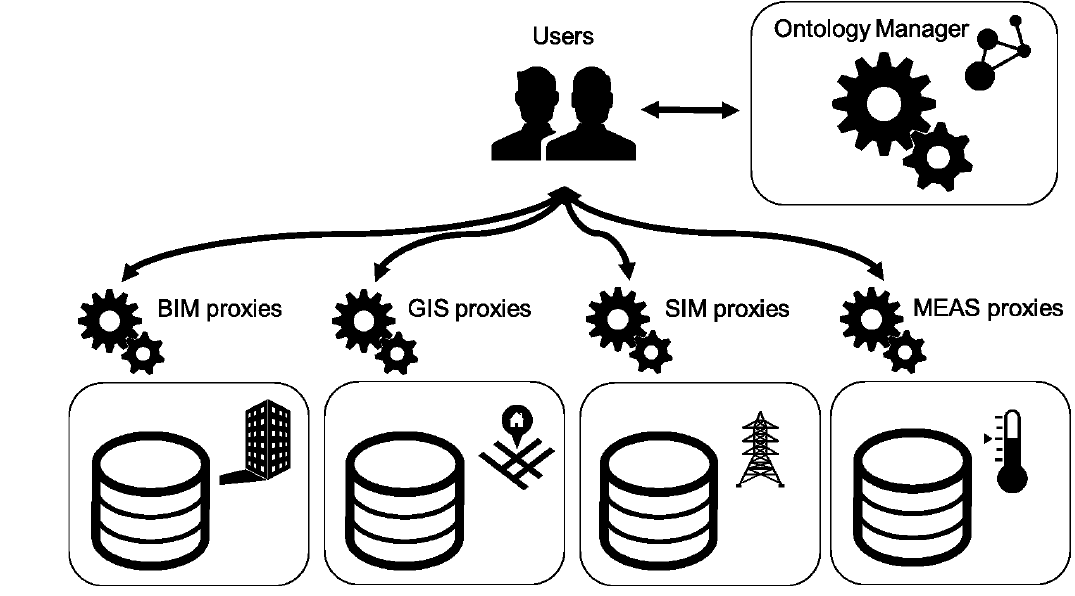
Figure 1. DIMCloud software infrastructure